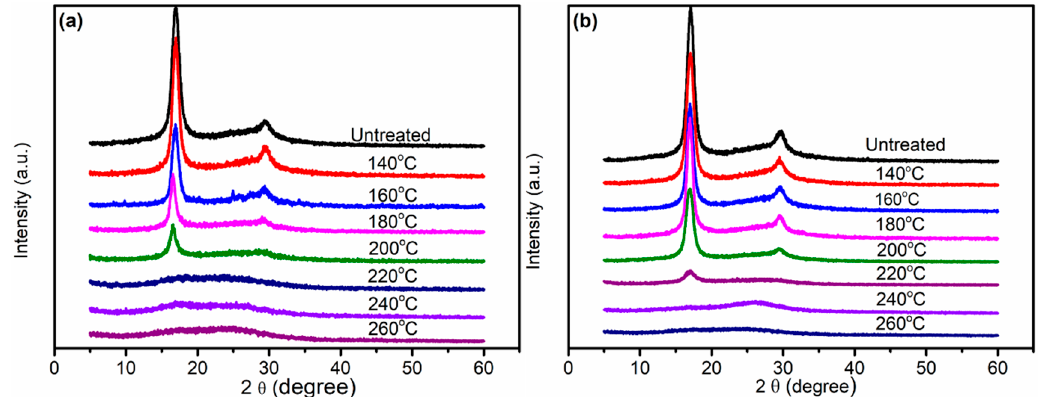
Figure 4. X-ray diffraction (XRD) patterns of PAN fibers treated at different temperatures: ( a ) in Sc-CO 2 ; ( b ) in air.